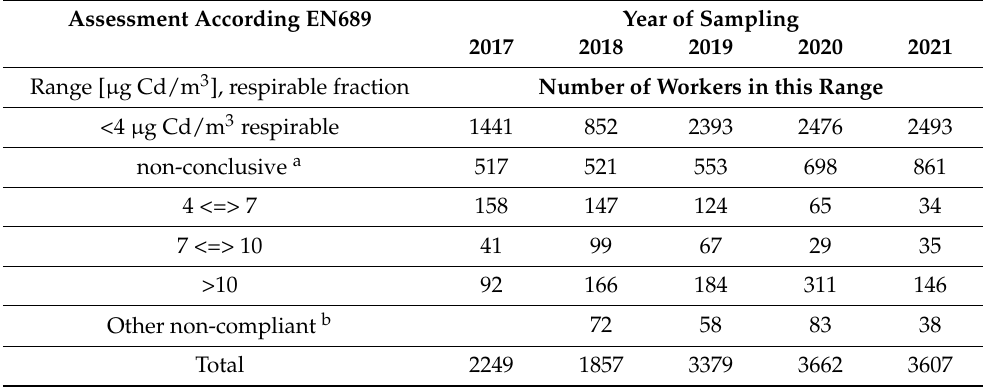
Table 4. ICdA cadmium in air workplace monitoring program “OCdAIR”: numbers of workers compliant ( ≤ 4 µ g Cd/m 3 ) using assessment criteria described in EN 689:2018. Assessment According